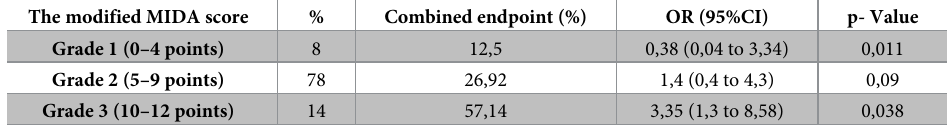
Table 7. Predictive values of grades of the modified MIDA Score: The Logistic regression analysis. The modified MIDA score % Combined endpoint (%) OR (95%CI) p- Value Grade 1 (0–4 points) 8 12,5 0,38 (0,04 to 3,34) 0,011 Grade 2 (5–9 points) 78 26,92 1,4 (0,4 to 4,3) 0,09 Grade 3 (10–12 points) 14 57,14 3,35 (1,3 to 8,58) 0,038 OR: Odds ratio.